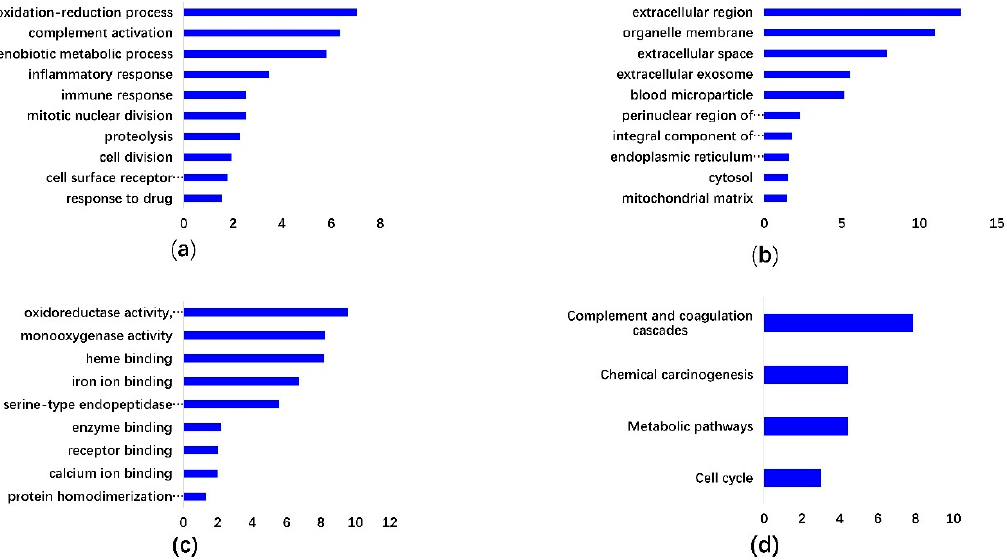
Figure 2. The significantly enriched Gene Ontology (GO) terms and Kyoto Encyclopedia Genes and Genomes (KEGG) pathways of hepatocellular carcinoma (HCC) di ff erentially expressed genes. ( a ) GO biological process, ( b ) GO cellular component, and ( c ) GO molecular function enrichment analysis results of DEGs. ( d ) GO KEGG pathway enrichment analysis of DEGs in HCC.